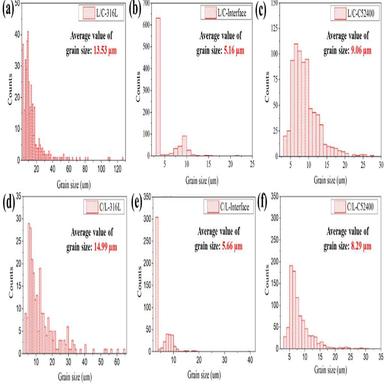
Grain size distribution at the dual interfacial regions: (a) (b) (c) at the L/C interface; (d) (e) (f) at the C/L interface.